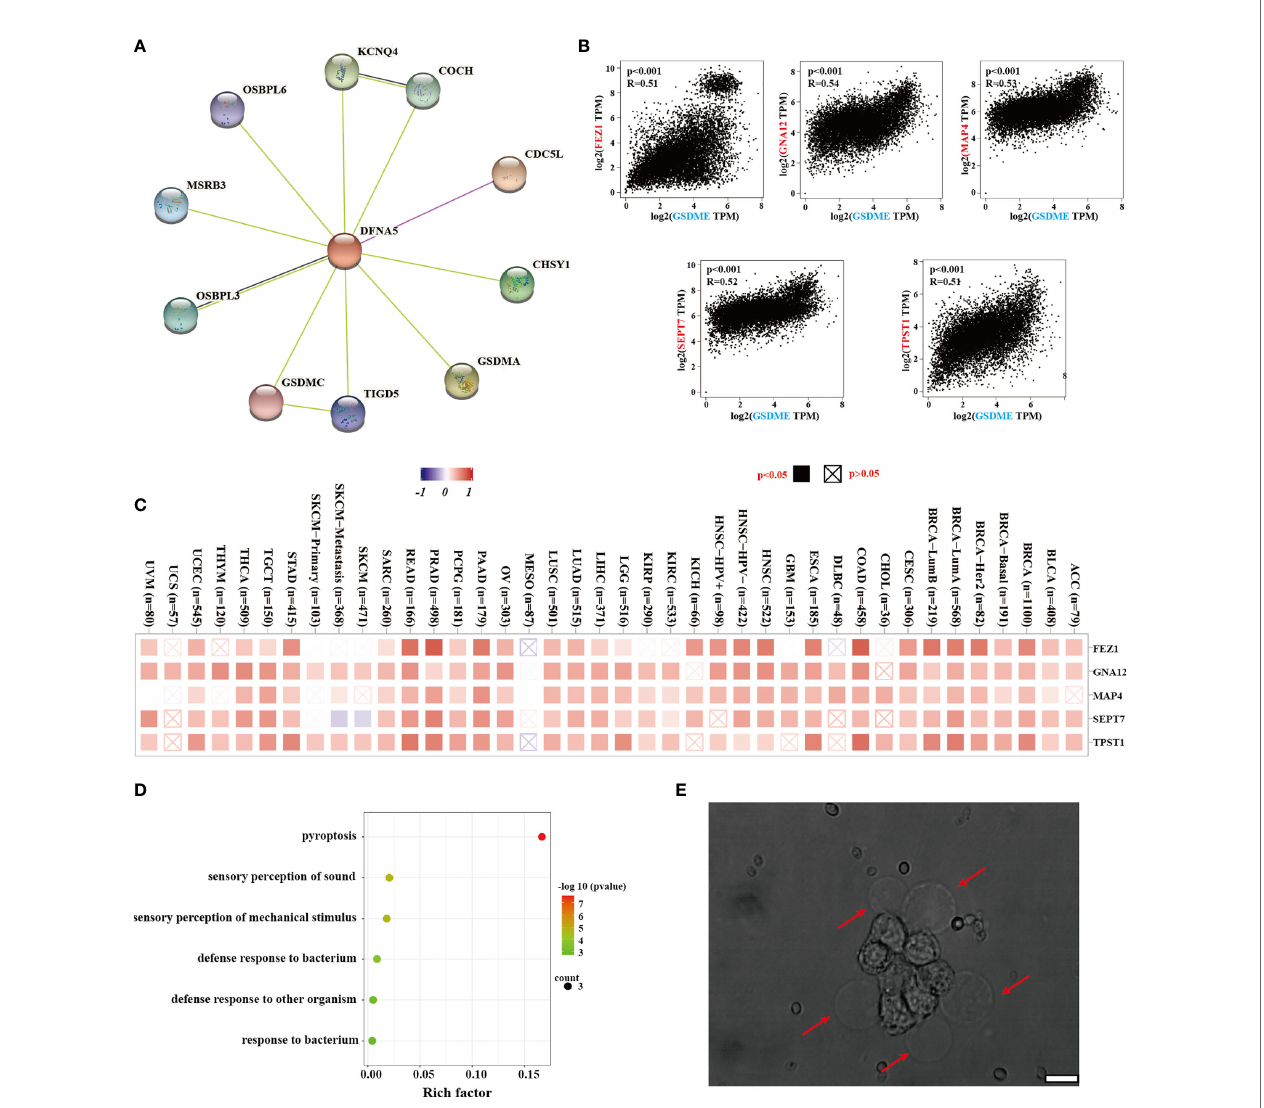
FIGURE 5 | (A) The available determined GSDME-related proteins from the STRING website. (B) The correlation between GSDME and selected binding genes, such as PEZ1, GNA12, MAP4, SEPT7 TPST1, and TBL2 from the GEPIA2 tool. (C) The corresponding heatmap data of different cancer types are graphed in detail. (D) GO analysis was displayed based on the GSDME-binding genes. (E) The typical morphology of pyroptosis in MCF-7 cells after apoptotic stimuli. Error bar: 200